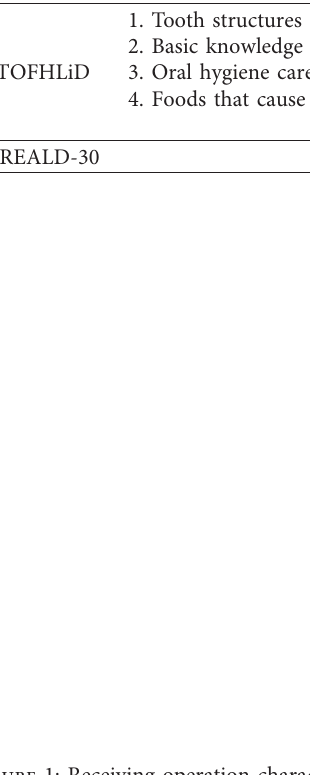
Table 3: Characteristics of OHL scores obtain from the P-TOFHLiD and the TH-REALD.